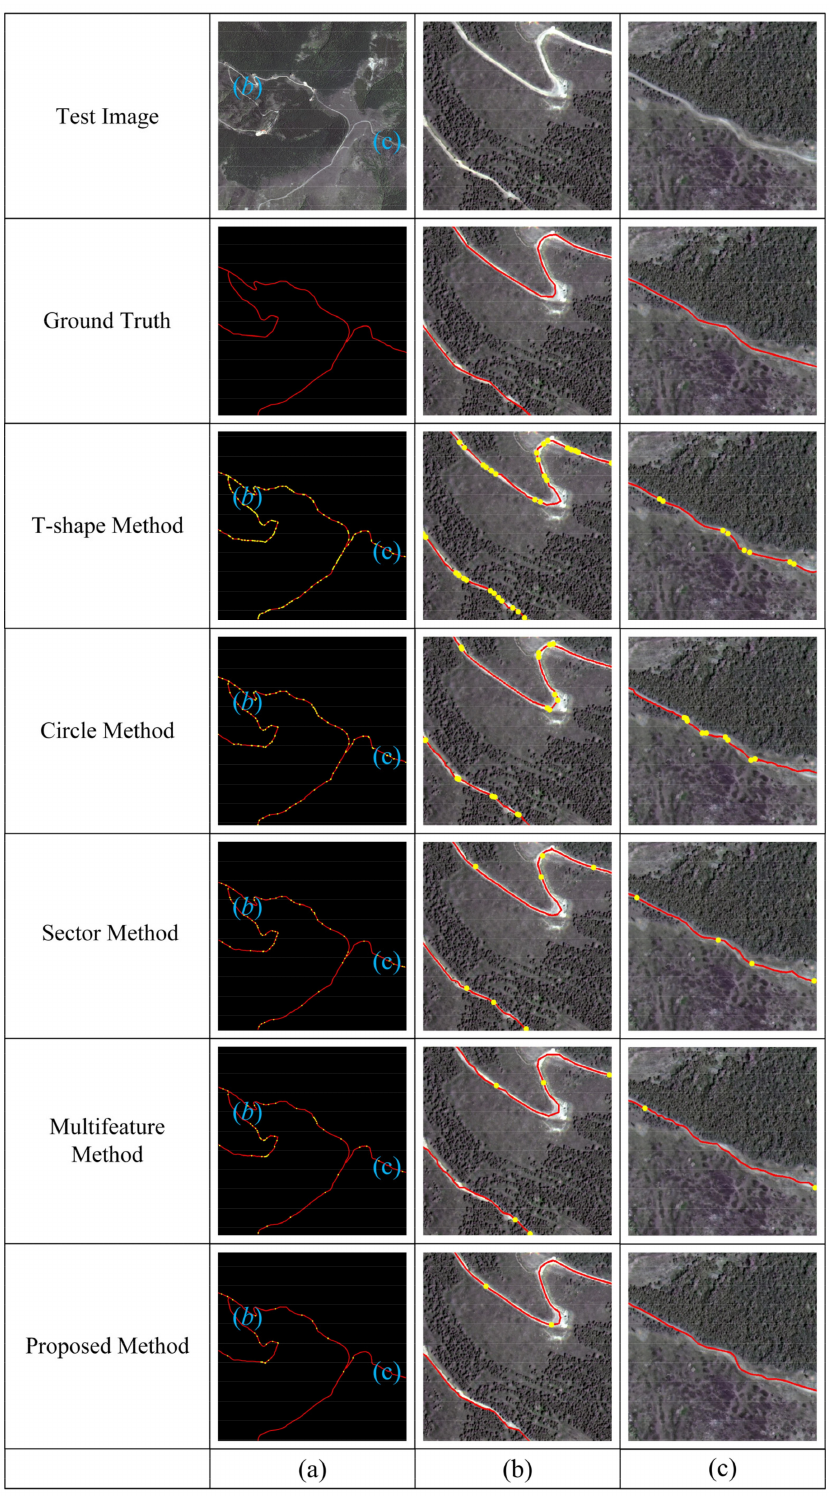
Figure 8. Road extraction results of the five methods analysed in Experiment 2. ( a ) Global graph. ( b ) Local magnification of region b. ( c ) Local magnification of region